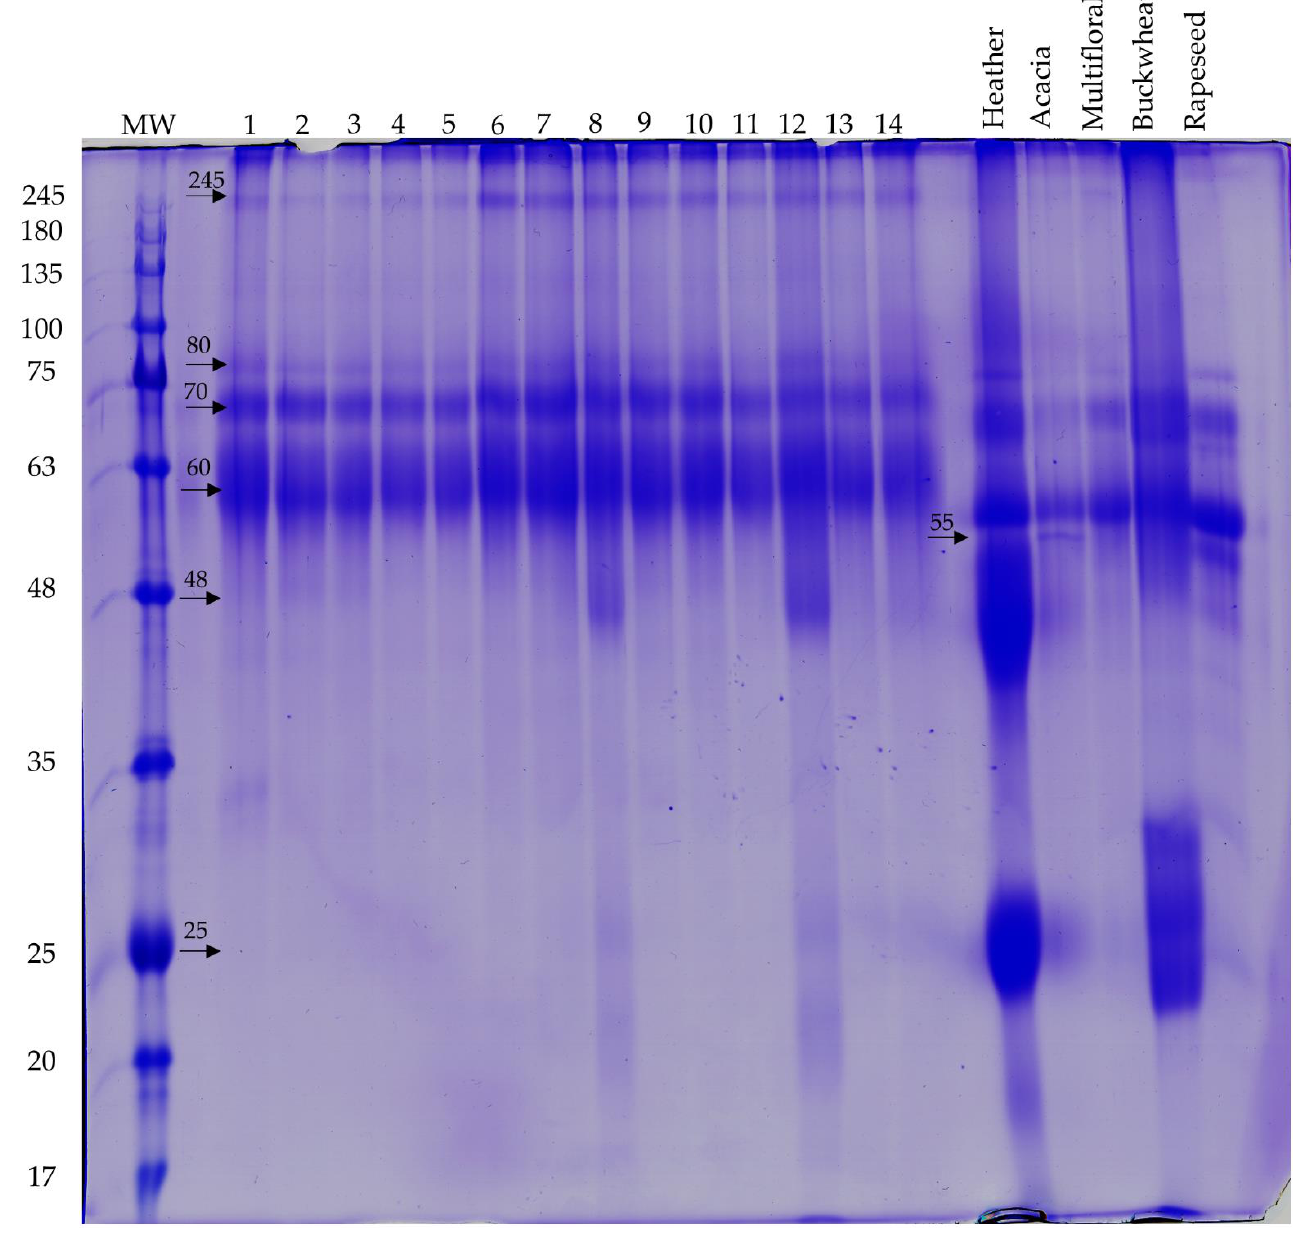
Figure 4. Qualitative SDS-PAGE gel stained with CBB-R. Arrows indicate the observed bands.